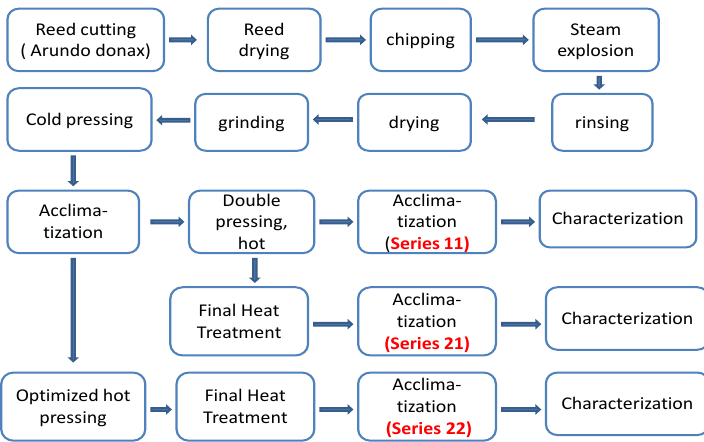
Figure 8. Diagram of production process for boards.